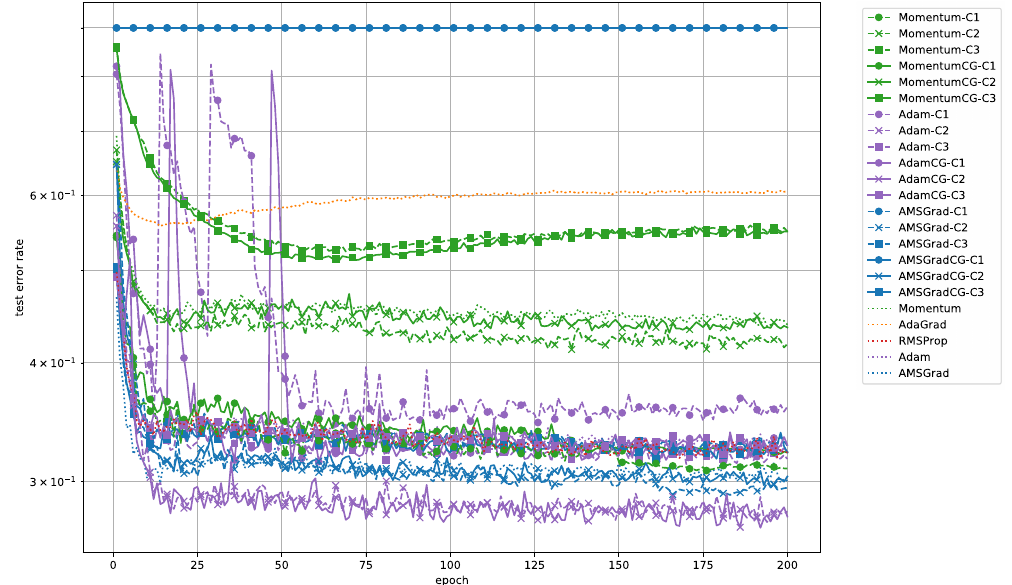
Figure 3. Classification error rate versus number of epochs on the CIFAR-10 dataset for testing